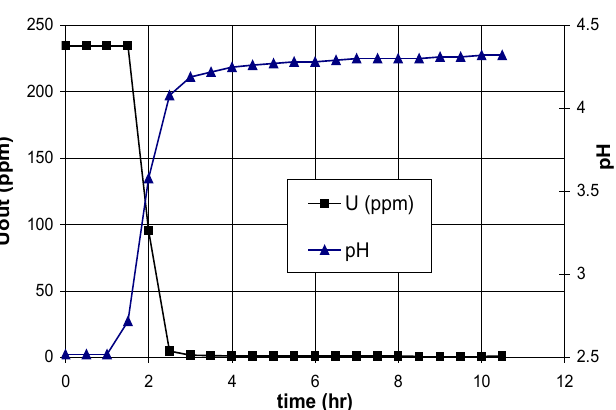
=280 ml, biomass bed